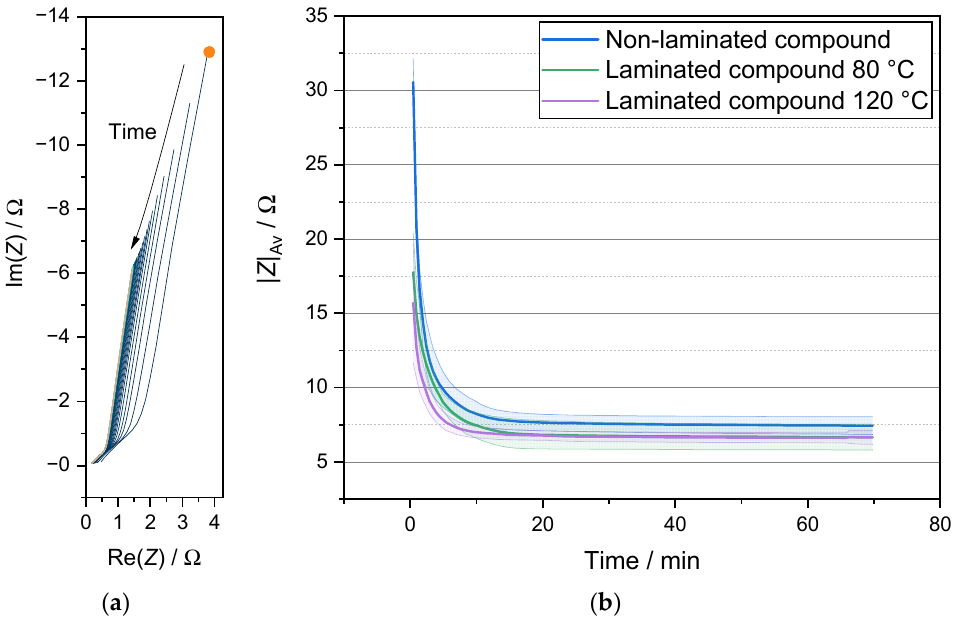
Figure 6. Nyquist representation of the time-dependent impedance outcome for one of the samples laminated at 120 °C ( a ). Averaged impedance modulus at 1 Hz as a function of time for the three investigated samples ( b